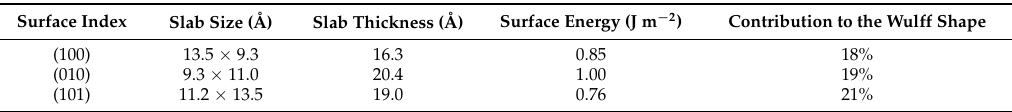
Table 1. Summary of the properties for the studied